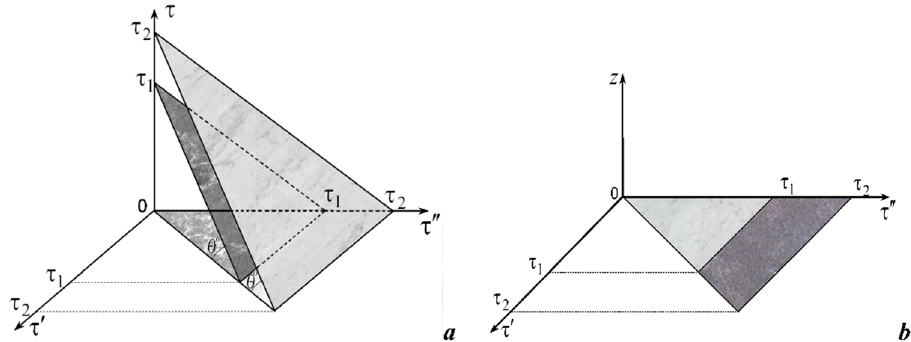
Figure 1. Region of integration in the space O ττ (cid:48) τ (cid:48)(cid:48) ( a ) and schematic representation of the set of integration regions in the space O τ (cid:48) τ (cid:48)(cid:48) z ( b ).